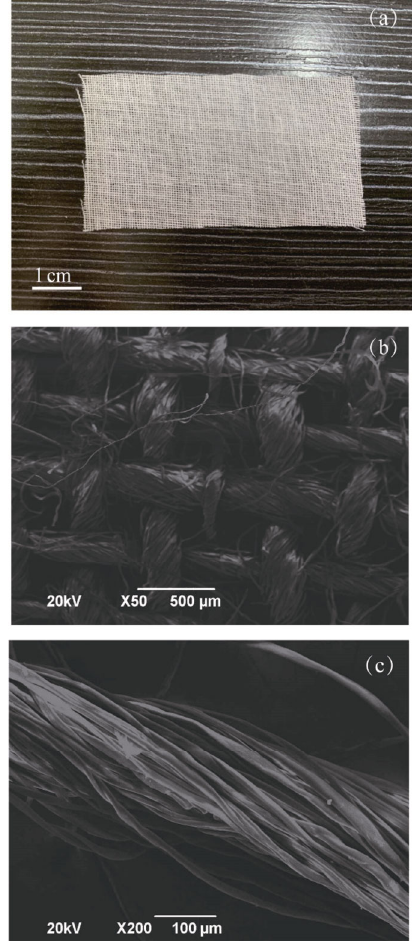
Fig. 1 Images of a cotton fabric under (a) low and (b) high magnification, and (c) SEM image of a single fiber.